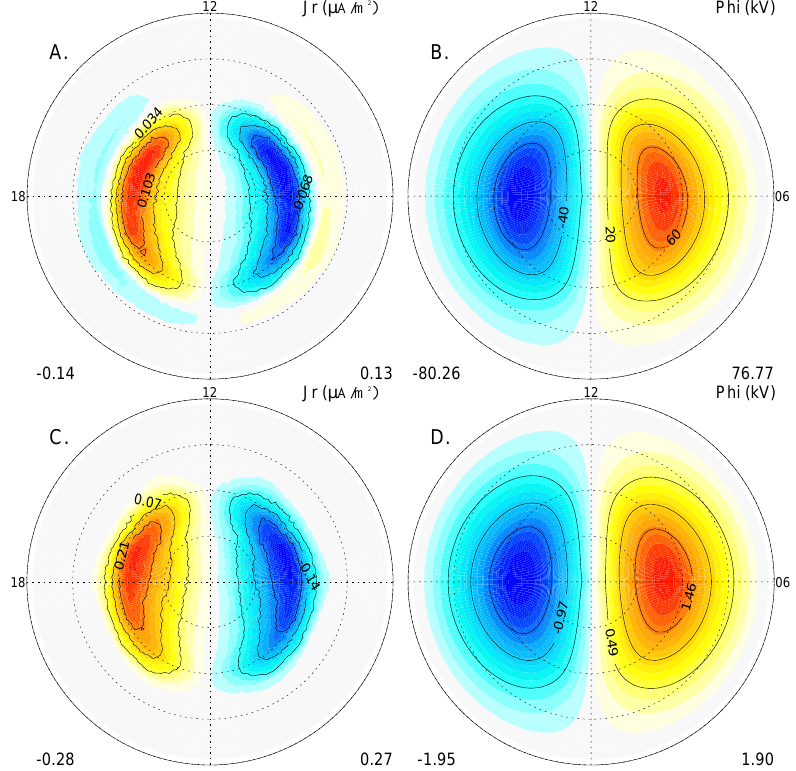
Plate 1. The (A, C) ionospheric field-aligned current and (B, D) potential patterns, plotted in magnetic latitude – magnetic local time coordinates, with noon being at the top and dawn to the right. The outer circle is 50 ◦ latitude, while the other rings mark 10 ◦ latitude. The MHD model was run with a Pedersen conductance of 1mho (A, B) and 100mhos (C, D). The color scale of each plot is independent of the other plots, while the maximum and minimum values are shown below each plot to the right and left,